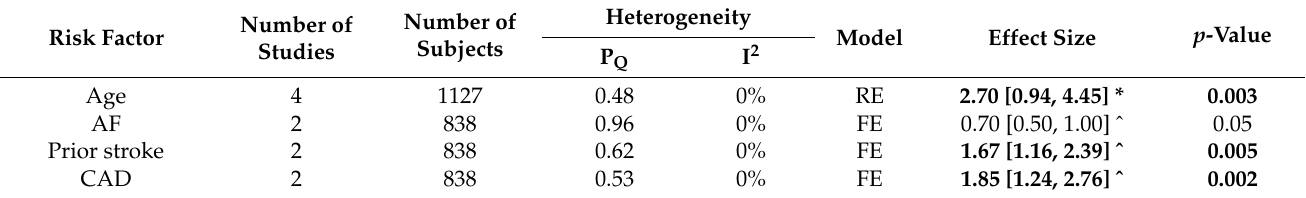
Table 3. Results of the current meta-analysis for the patients with ICH and/or